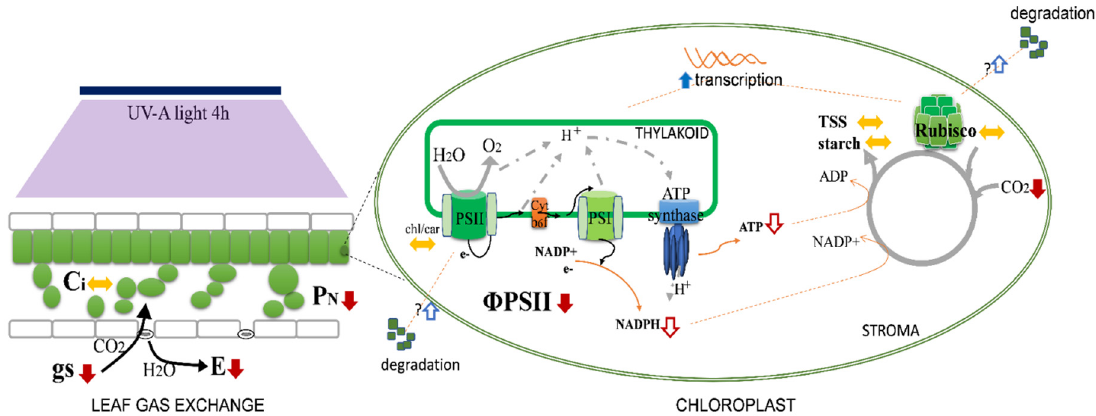
Figure 6. Major photosynthetic impacts and changes induced by moderate UV-A 4 h/day, for 30 d, in tomato flowering plants. Overall, the PSII fluorescence is affected by the decreased efficiency of Φ PSII, although LHC-pigment (Chl/car = chlorophyll/carotenoids) levels are not affected. This leads to fewer electrons being transported and thus a decrease in NADPH and ATP production and availability for the Calvin cycle. This reduction is related with the decrease in the net photosynthetic rate (P N ), meaning that internal CO 2 concentration (Ci) is not so depleted, and the stomatal conductance (gs) may decrease, therefore decreasing transpiration rate (E). Simultaneously, a degradation of RuBisCO may occur, but it can be replaced by new protein due to the stimulated accumulation of its transcripts (and increase its transcription), which overall may reset the negative impacts on the Calvin cycle, thus not having negative impacts on total amounts of soluble sugars and starch. Solid red arrows mean a decrease and solid blue arrows an increase. Dashed red and blue arrows mean a putative decrease and increase, respectively.